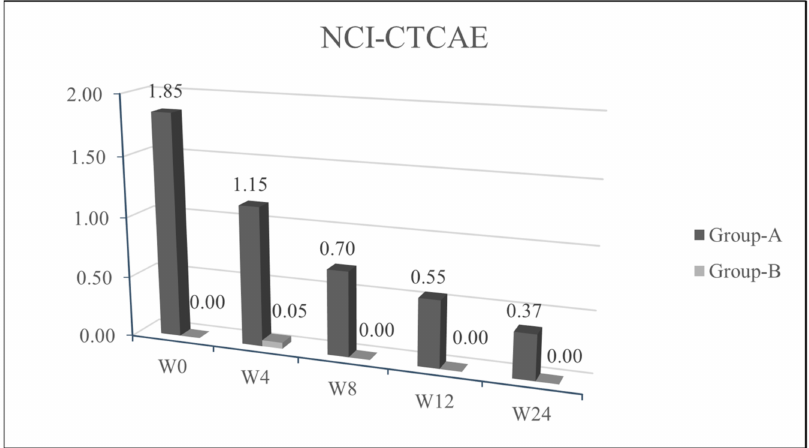
Figure 1. Average values of National Cancer Institute Common Terminology Criteria for Adverse